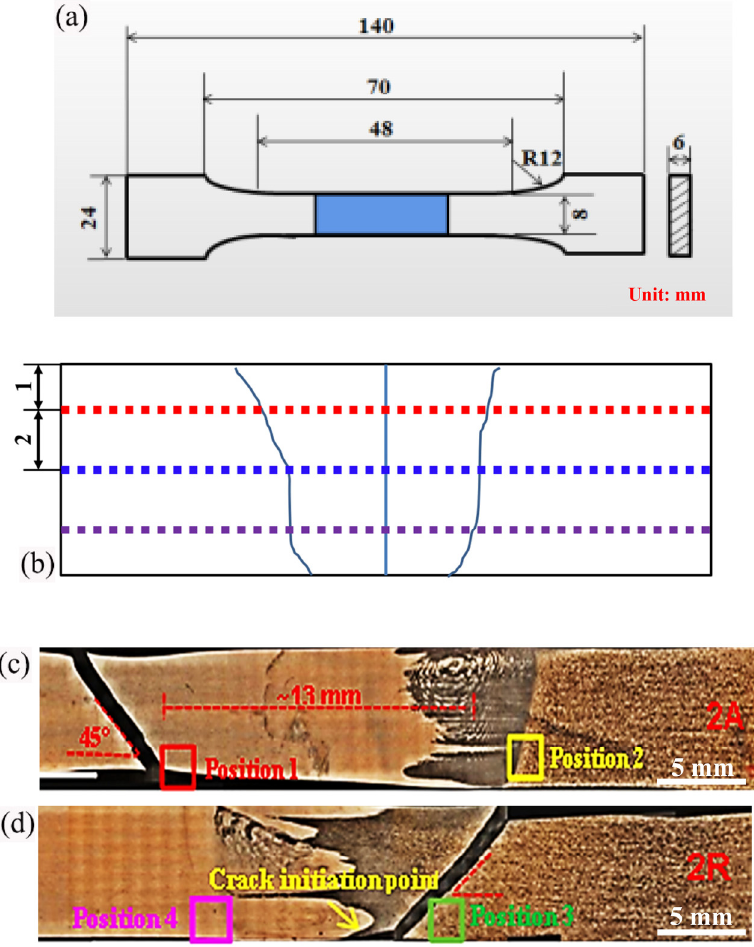
Figure 2. Schematic diagram of tensile specimen ( a ), hardness test ( b ) and sections of the welded structure observed by metallographic examination ( c ) 2A5R, ( d ) 5A2R.